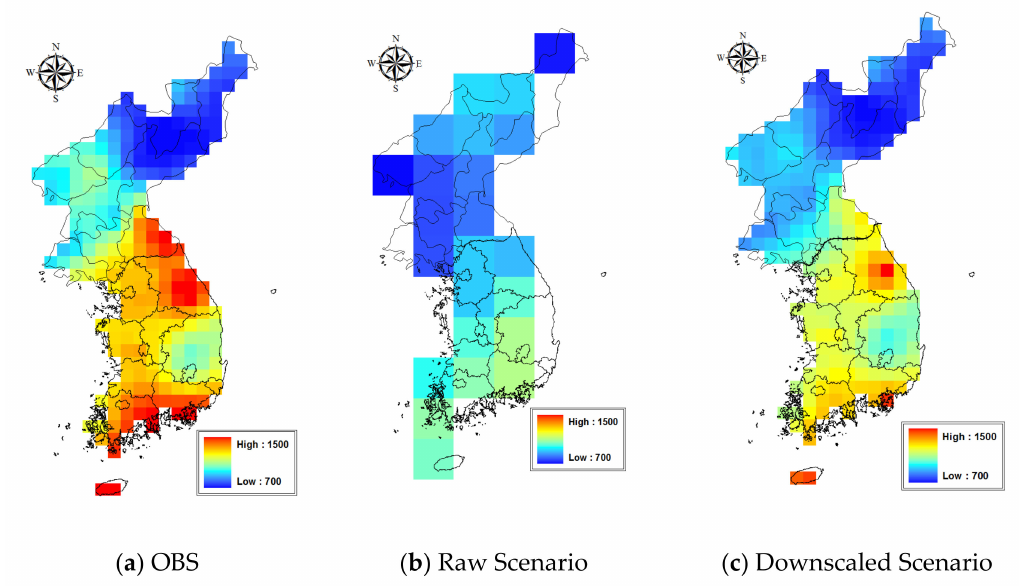
Figure 8. Spatial distribution for observation and pre-/post-downscaling. The high monthly variability in precipitation episodes that the Korean peninsula has experienced require further analysis. Figure 9 presents a box plot for monthly precipitation. The box plot suggests that MME averages are very close to those from observation data. The months with high precipitation, June and August, see high variability.